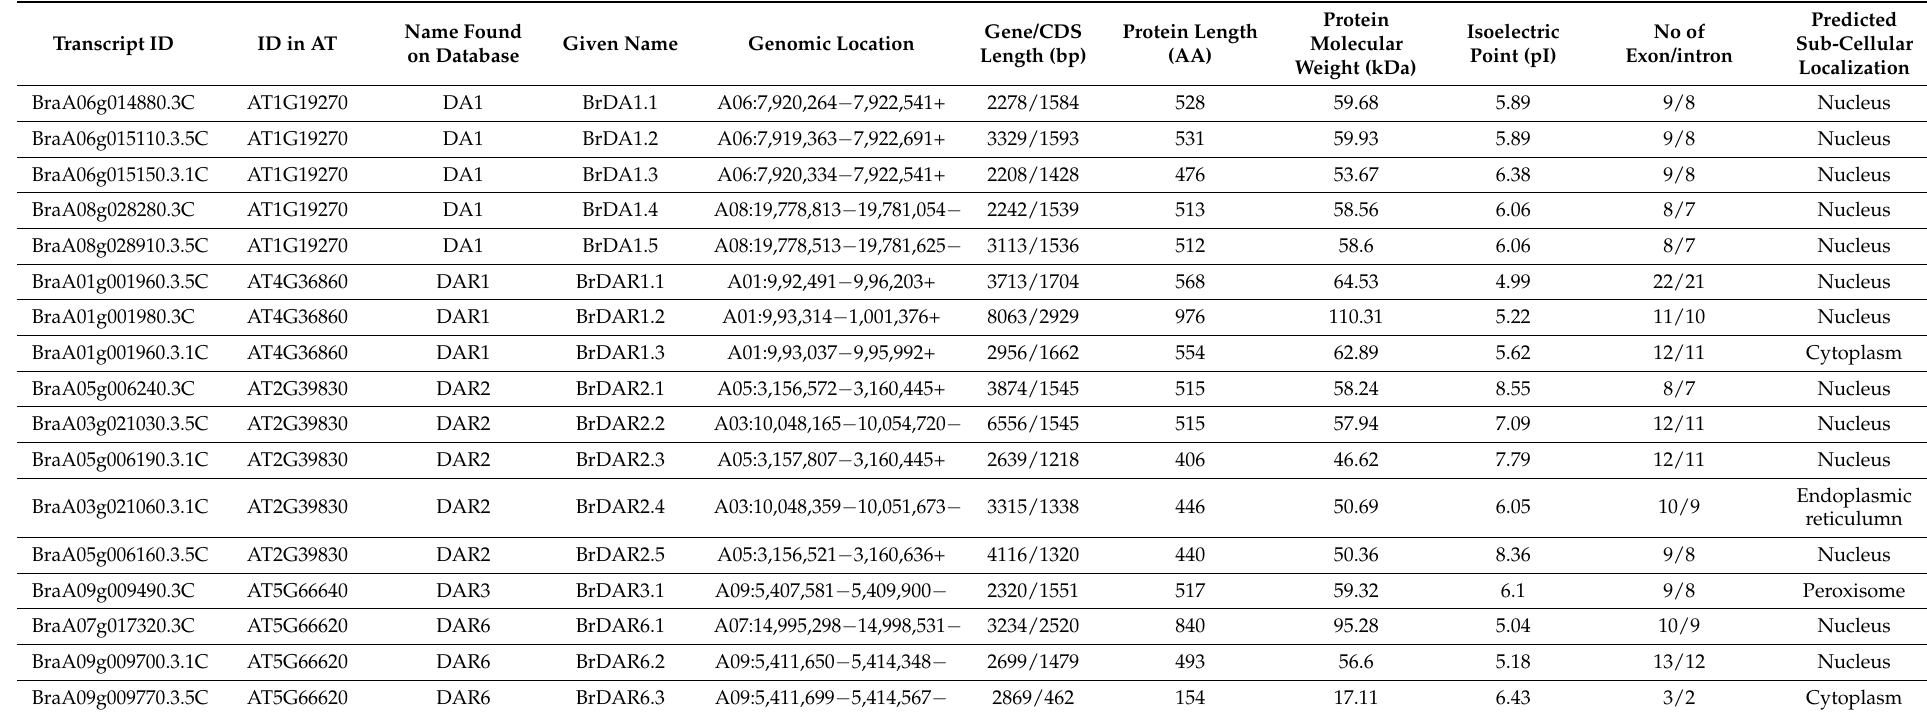
Table 1. Detailed information of 17 BrDA1 & DAR gene